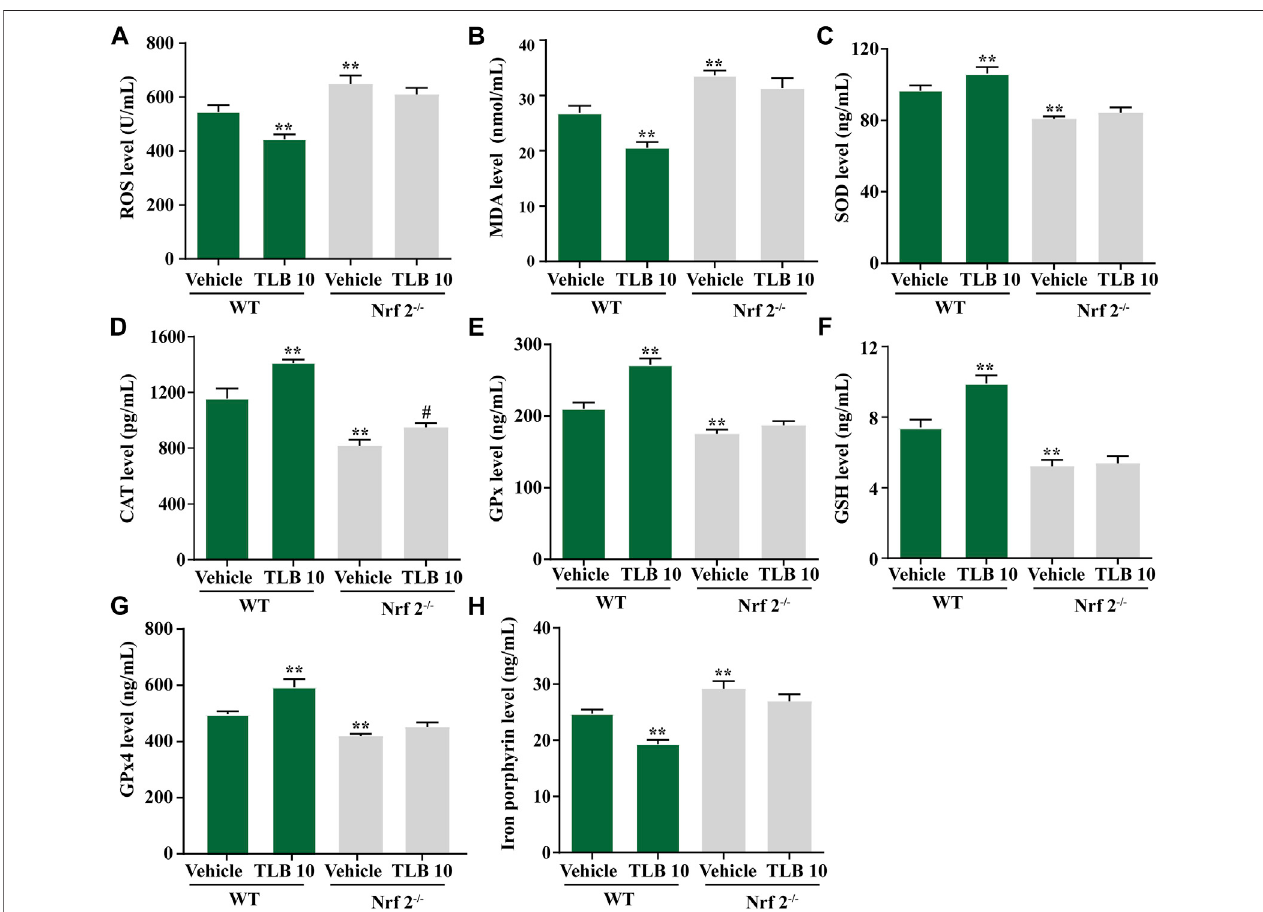
FIGURE6 | Effect ofTLB on EEIF-induced oxidativestress and ferroptosis in Nrf2 − / − mice. (A) ROS level, (B) MDA level, (C) CAT activity, (D) SOD activity, (E) GPx activity, (F) GSH level, (G) iron porphyrin, and (H) iron porphyrin. The data were presented as the mean ± SEM ( n = 10). * p < 0.05 and ** p < 0.01 vs vehicle group. # p < 0.05 vs Nrf2 − / − vehicle